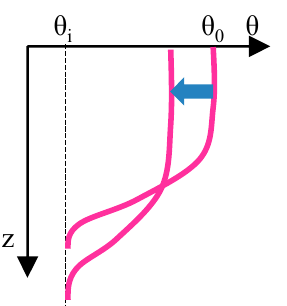
Figure 3. Graphical representation of the soil water redistribution process.